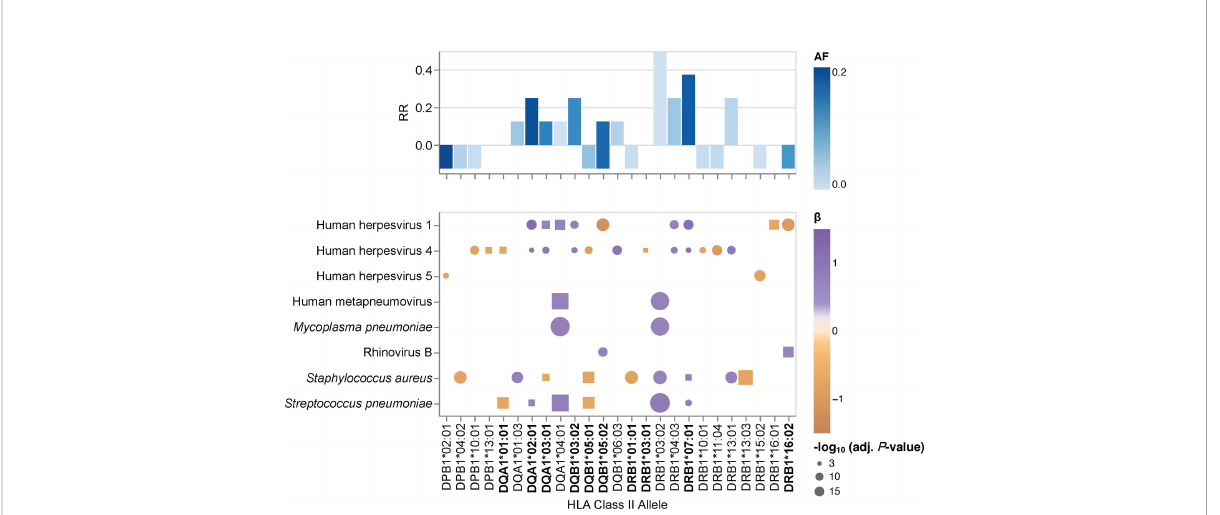
FIGURE 2 HLA class II allele-speci fi c effects on the antibody repertoire breadth against common microbial infections. Heatmaps depicting signi fi cant associations (adjusted P -value ≤ 0.005) between speci fi c alleles and the antibody repertoire breadth against common microbial infections. The coef fi cient ( b ) and direction of associations are indicated by a color gradient for each circle. The symbol size depicts the -log 10 (adjusted P - value) of the association. Round symbols show aggregated P -values for associations that reached statistical signi fi cance when using results from both HLA typing methods (i.e., HLA*LA and HLA-HD) as explanatory variables. Square symbols show P -values when associations reached statistical signi fi cance with only one of the two HLA typing methods used (i.e., either HLA*LA or HLA-HD). Associations for alleles labeled in bold were also found for the corresponding haplotypes listed in Supplementary Table 7. Bar plots depicting the antimicrobial response ratio (RR) for each allele or haplotype. The allele frequency is indicated by a color gradient for each